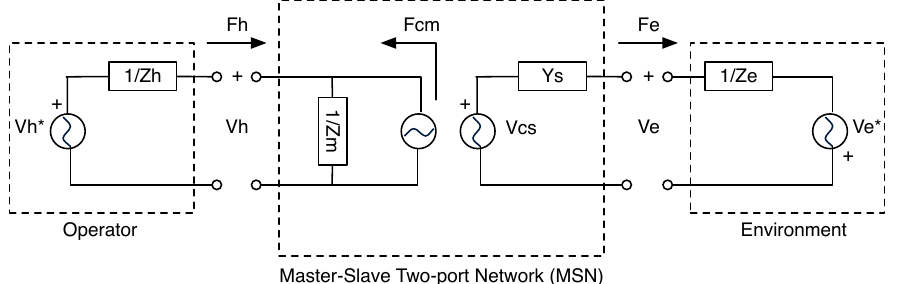
Figure 6. Master-slave two-port network (MSN) block